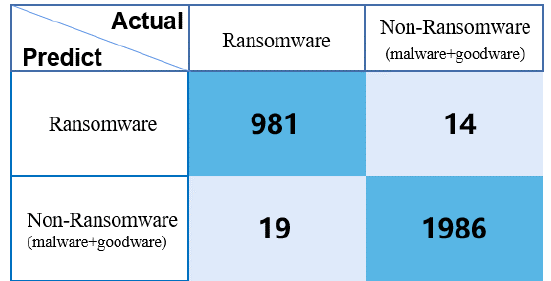
Figure 6. The confusion matrix of experiment